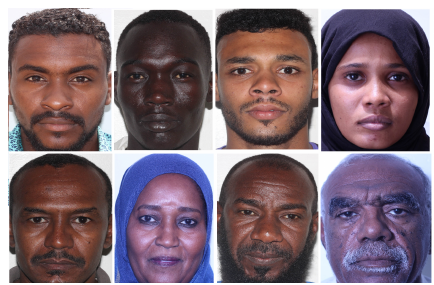
Figure 2. A sample of images from Sudanese dataset.